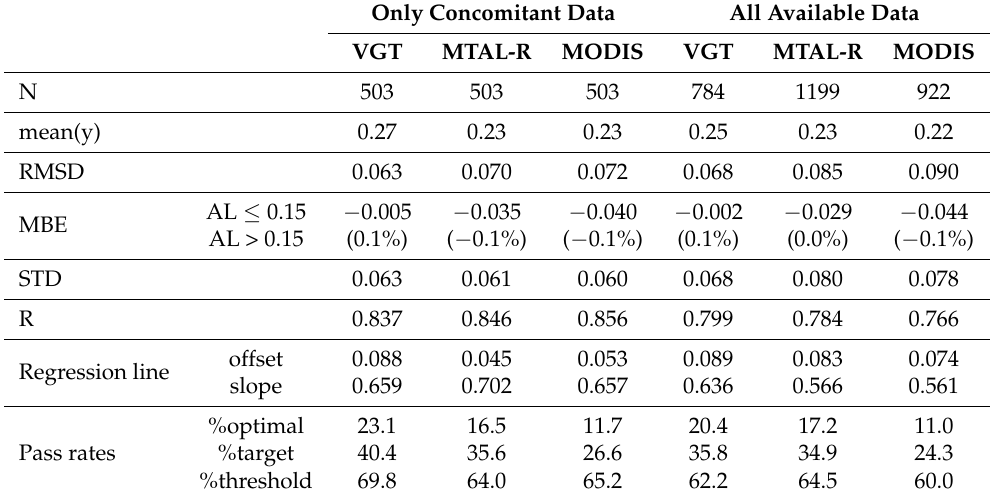
Table 8. Accuracy assessment of VGT, MTAL-R and MODIS surface albedo satellite products versus ground measurements coming from GBOV, AMMA and BSRN stations during the 1 January 2009–31 December 2012 period when those dates that provided concomitant data for all three satellites products and ground measurements were considered (left) or simply using all data available (right). Absolute MBE are calculated over albedo values less 0.15 while relative MBE (in %) are calculated over albedo values greater than 0.15. Only Concomitant